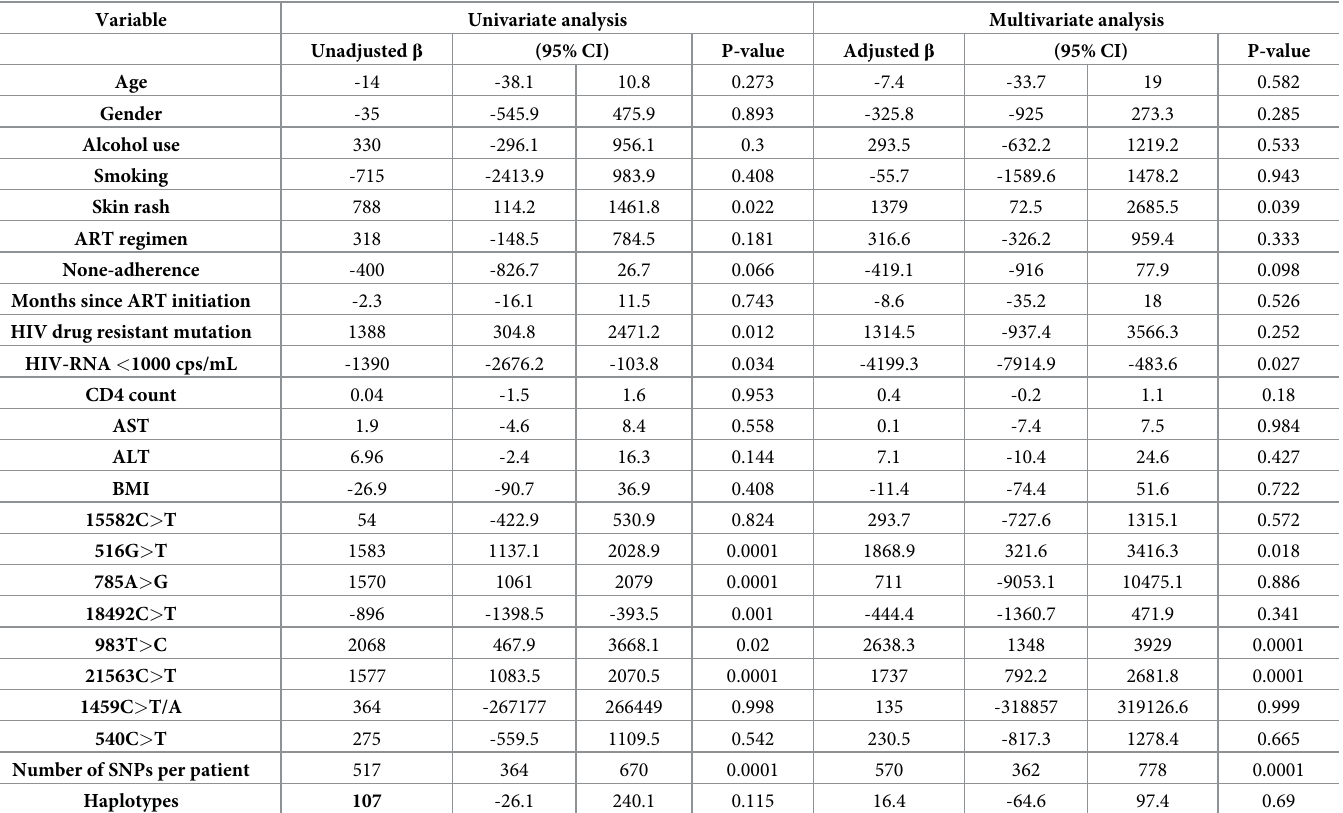
Table 5. Quartile regression analyses of factors associated with EFV plasma